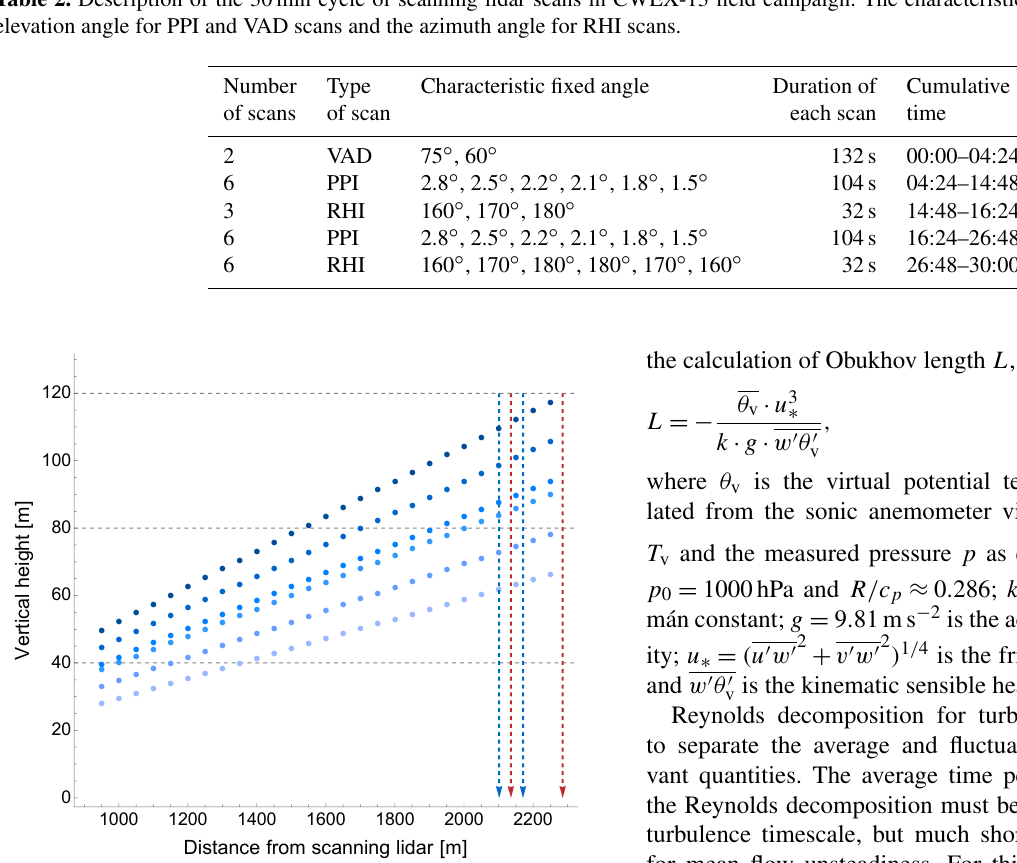
Figure 2. Schematic representation of the position where measure- ments from PPI scans are available, at six different elevation angles, as a function of the distance from the scanning lidar. The horizontal dashed lines show the vertical limits of the rotor disk of the turbines and hub height. The position of the four turbines is represented by the vertical dashed lines, with red lines for outer turbines and blue lines for inner turbines. From the westernmost to the easternmost turbine, the distances from the scanning lidar are 2136, 2102, 2171, and 2286m. The change in elevation between the turbine location and the lidar location (7m) is taken into